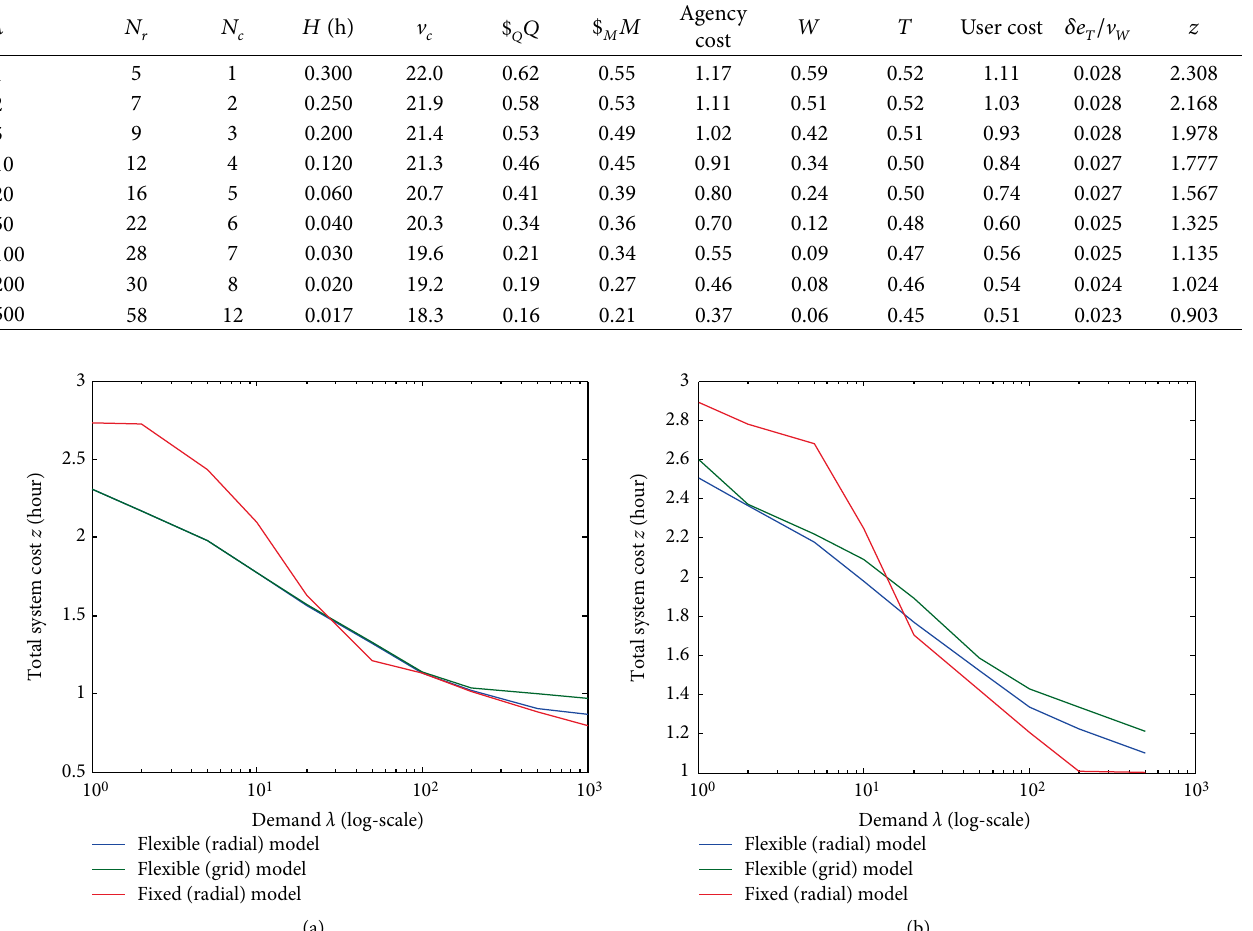
Table 3: Optimal decision variables and cost components.